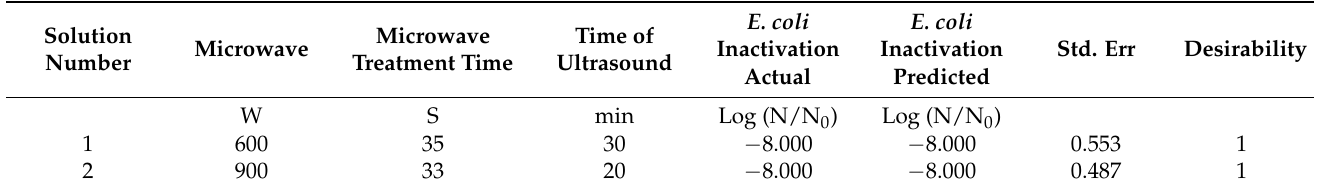
Table 4. Validation of the RSM-optimized quadratic model for E. coli inactivation by microwave and ultrasound in an orange juice